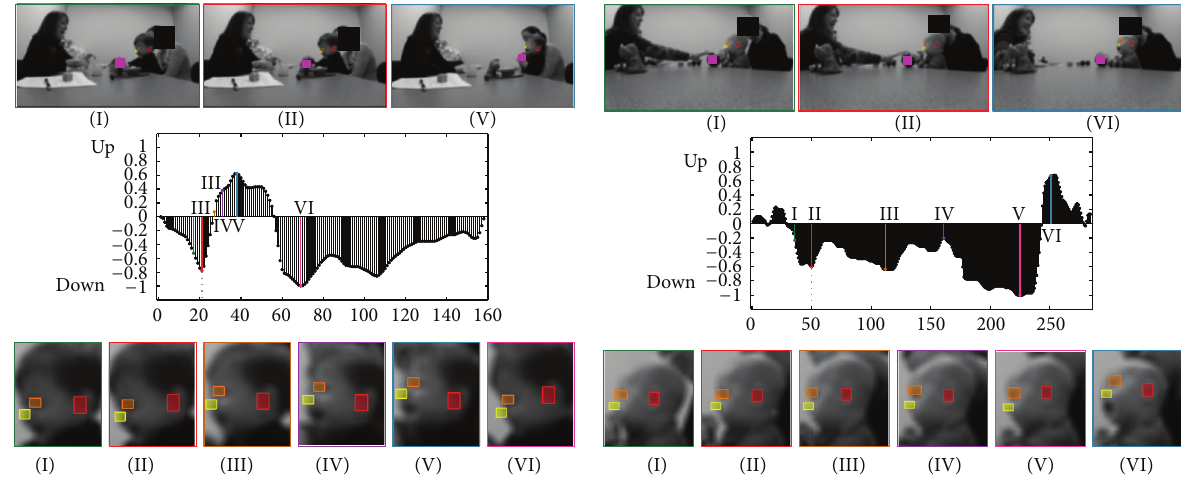
Figure 4: Two examples of the ball playing activity. Top: when the ball contacts the child, when the child looks down at the ball, and when the child looks up at the clinician. Middle: changes in the pitch motion ( 𝑦 -axis) for each frame ( 𝑥 -axis). The dotted line represents when the ball contacts the participant. Bottom: 6 examples of the infant’s face during the administration. All facial features are automatically detected and tracked. Colors and roman numerals identify corresponding images and spikes in the graph.